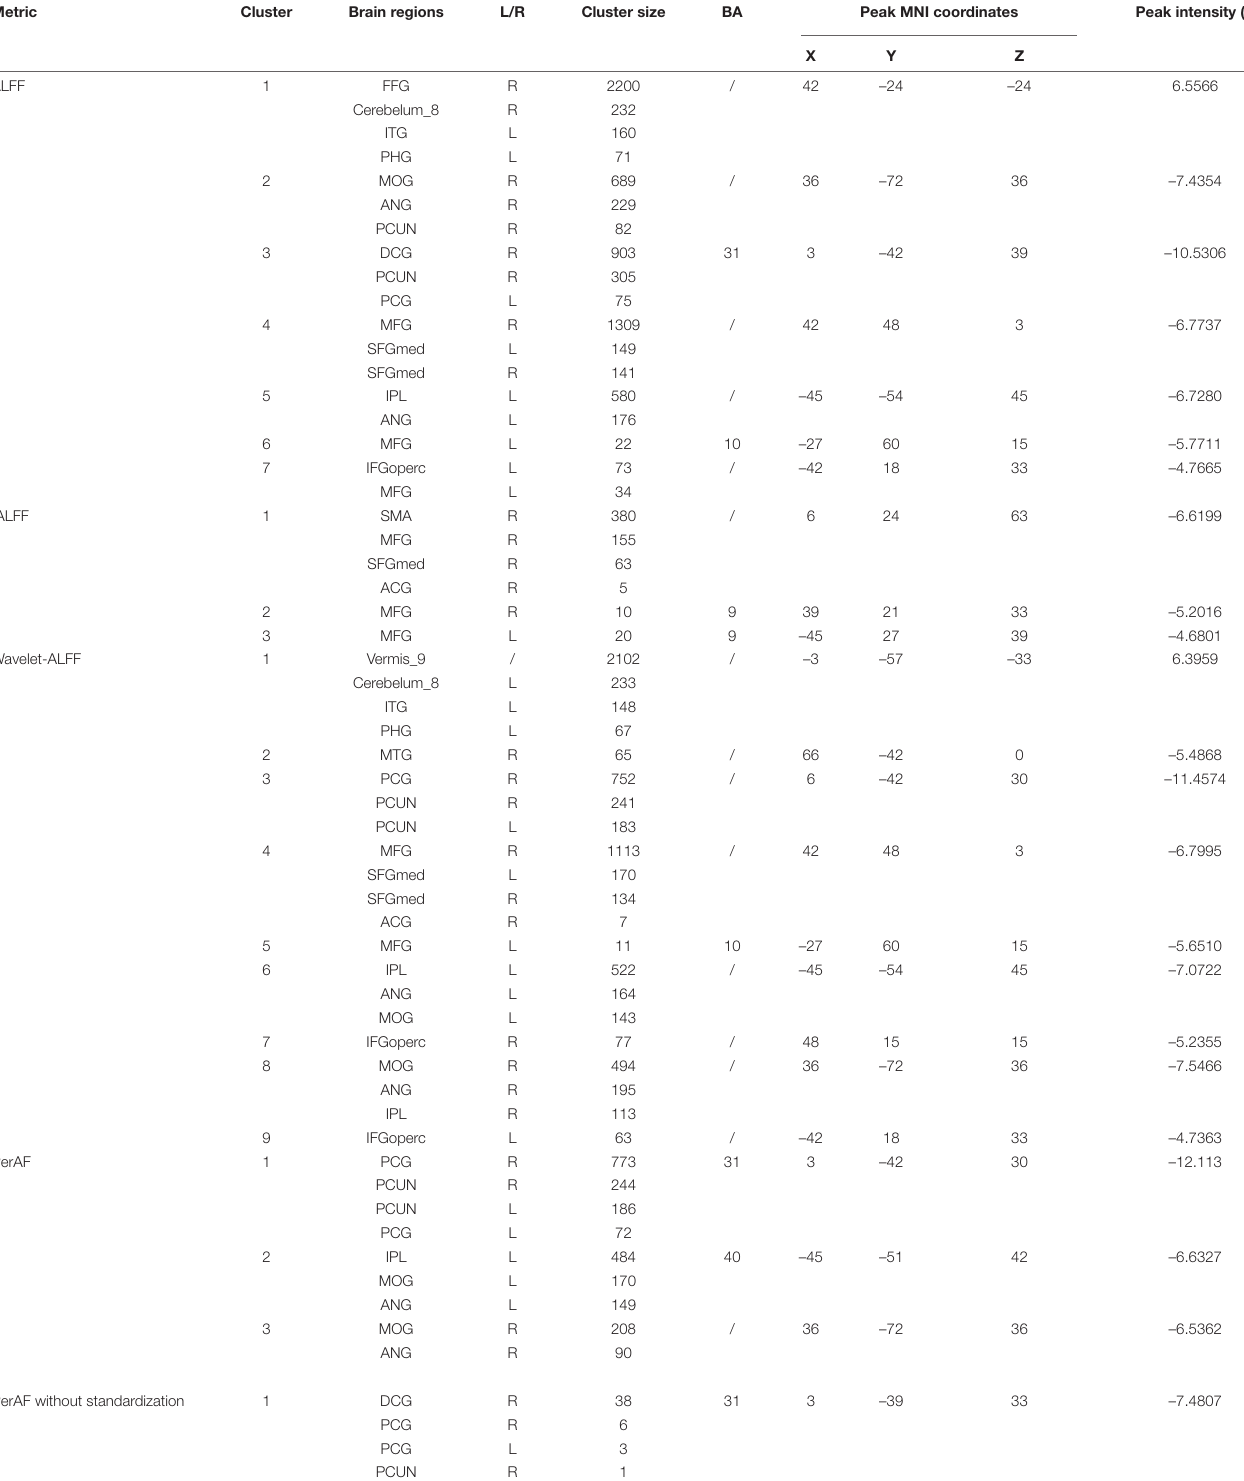
TABLE 2 | Brain regions showing differences in ALFFs, fALFFs, Wavelet-ALFFs, and PerAF with/without standardization between the groups. Metric Cluster Brain